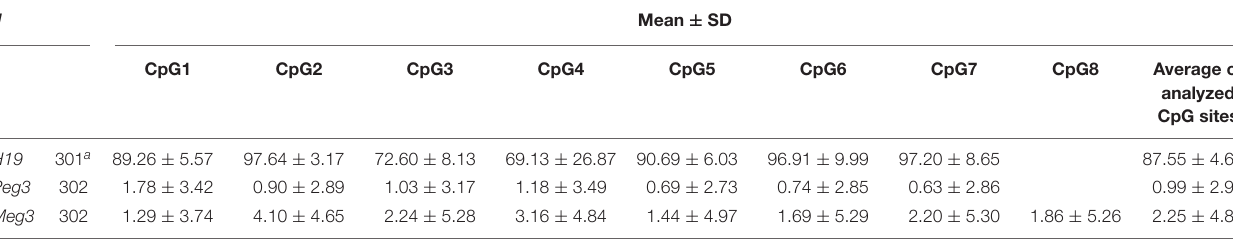
TABLE 4 | Methylation levels in the sperm DNA (%).